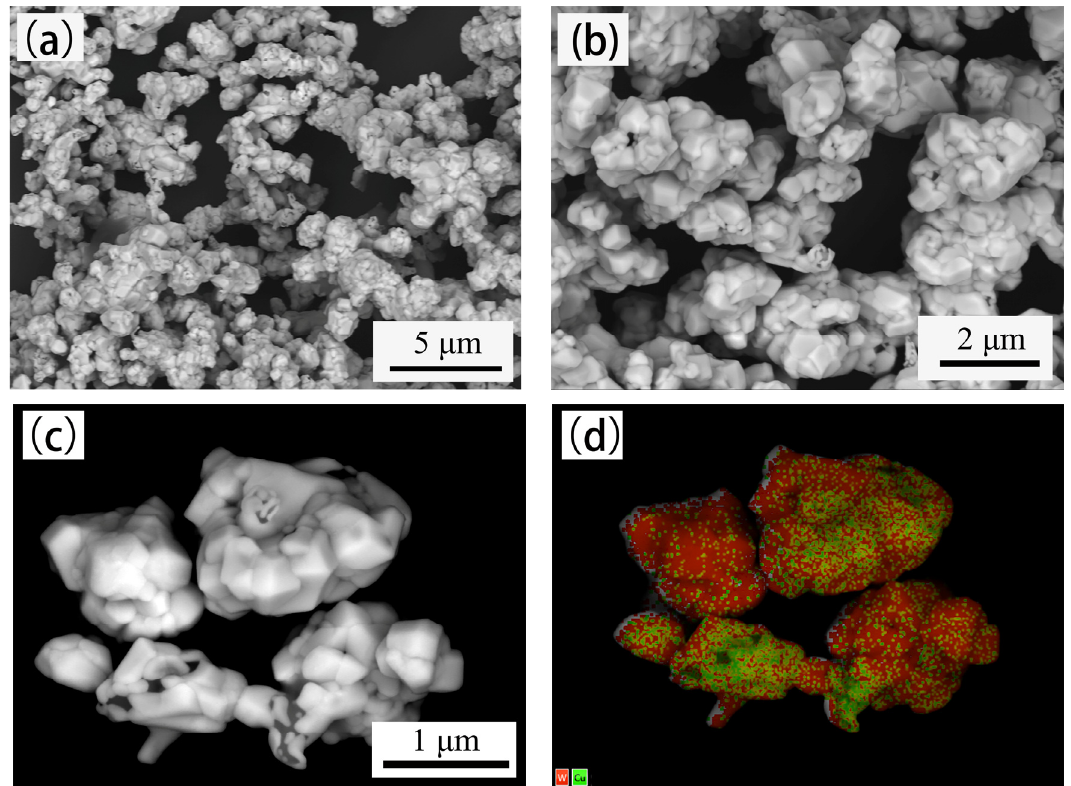
Figure 1. Micromorphology of W–20% Cu powders synthesized by thermochemical method (powder A). ( a ) 5000 × magnification; ( b ) 10,000 × magnification; ( c ) 25,000 × magnification; ( d ) EDX mapping analysis of (c).